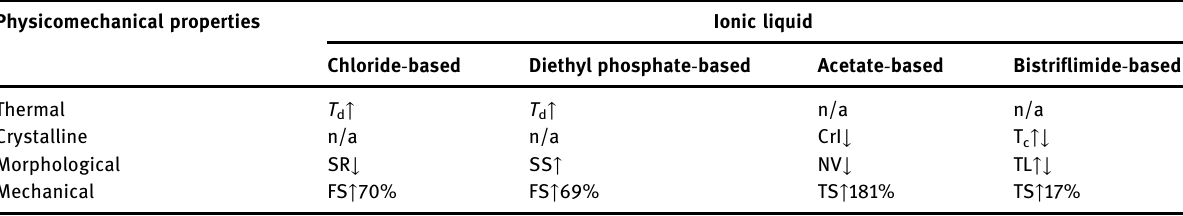
Table 7: Summary of physicomechanical properties of polymer biocomposites pretreated with four types of ionic liquids Physicomechanical properties